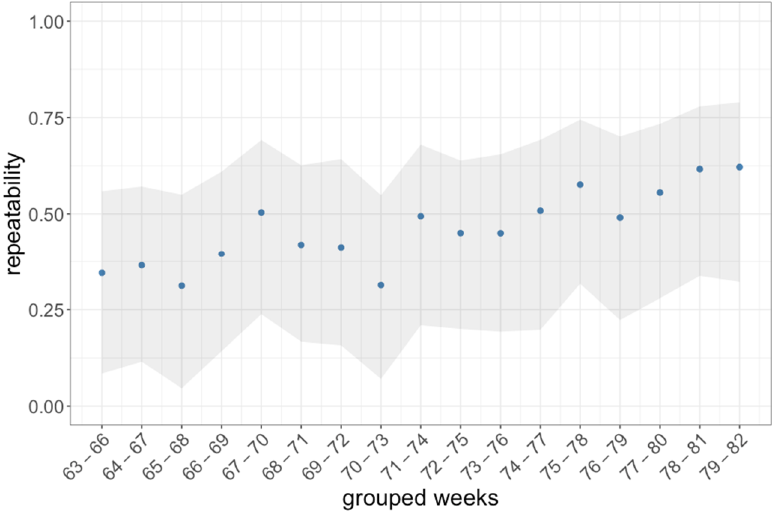
Figure 8. Calculated repeatability for the RE with the animal ID as a random factor. Each repeatability value (R, blue dots) was calculated over time periods of four weeks resulting in 17 groupings. The repeatability was estimated with a linear model. The grey areas depict the confidence intervals (2.5% and 97.5%) resulting from 500 bootstrapping runs and 100 permutations (R package ‘rptR’, function ‘rpt()’).